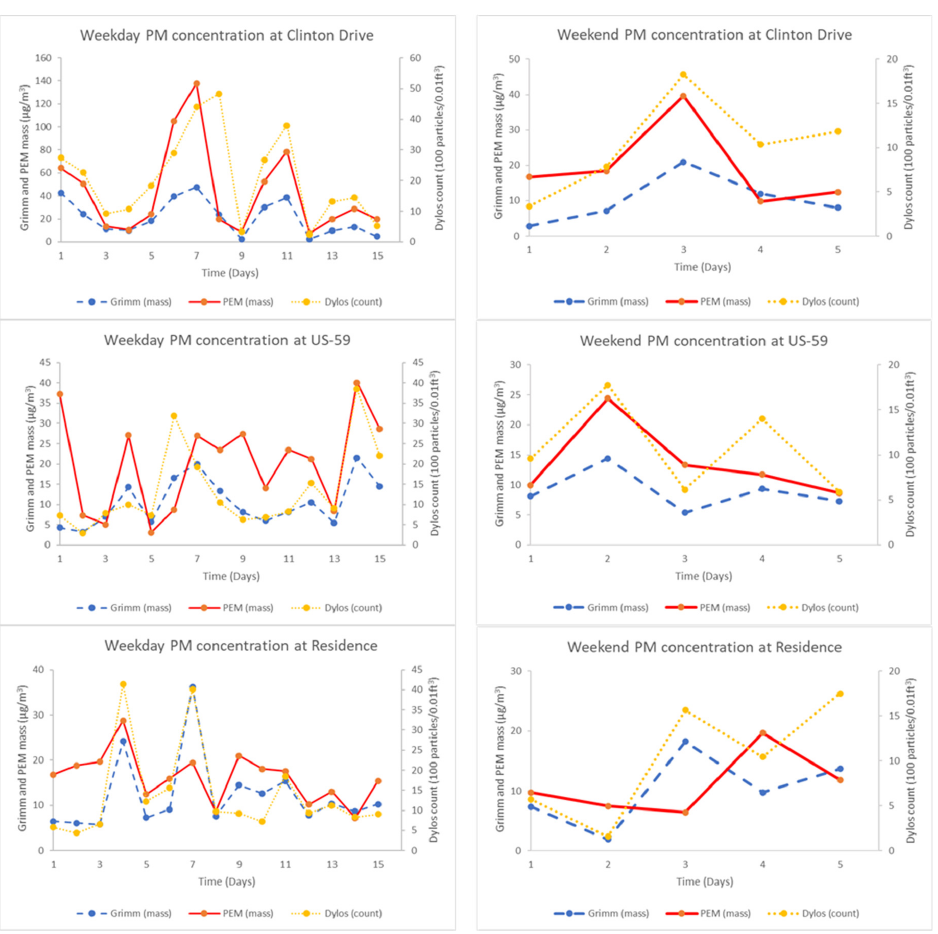
locations combined.